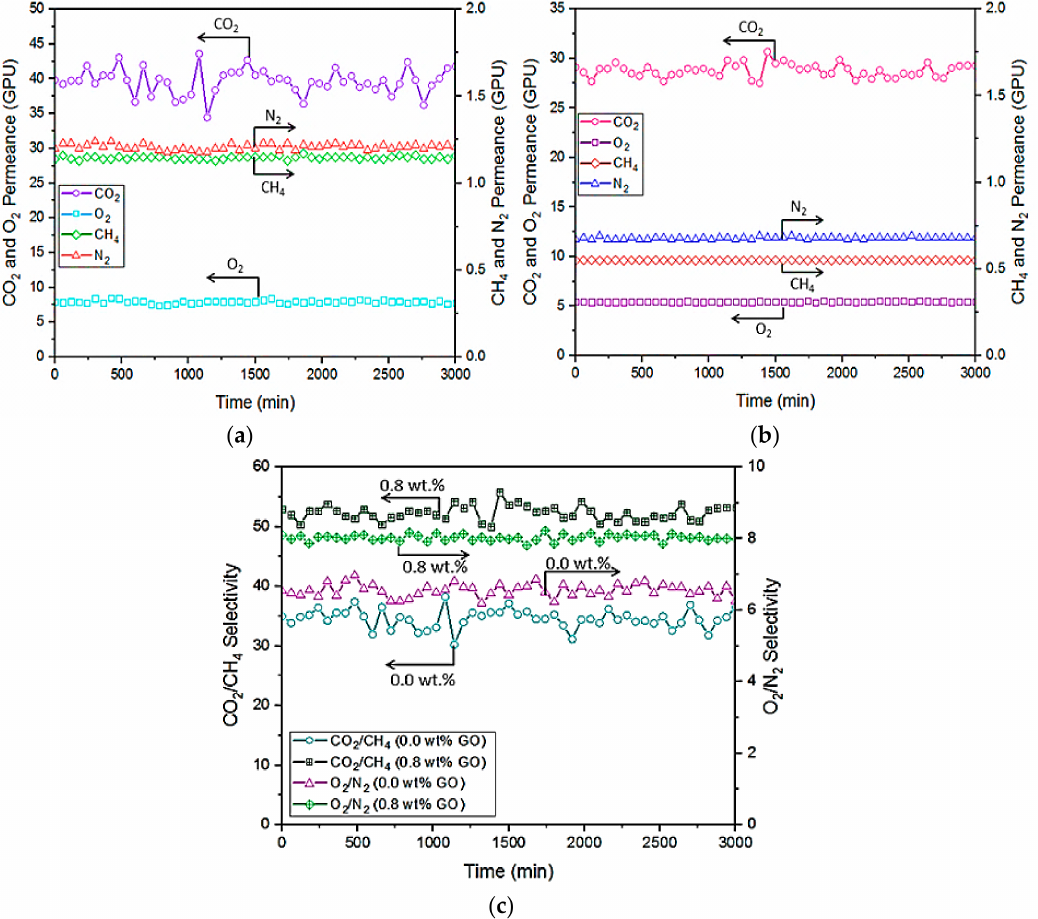
Figure 10. Long-term performance stability of multilayer-coated membrane without GO ( a ) and with 0.8 wt% GO ( b ) and their respective gas pair selectivity ( c